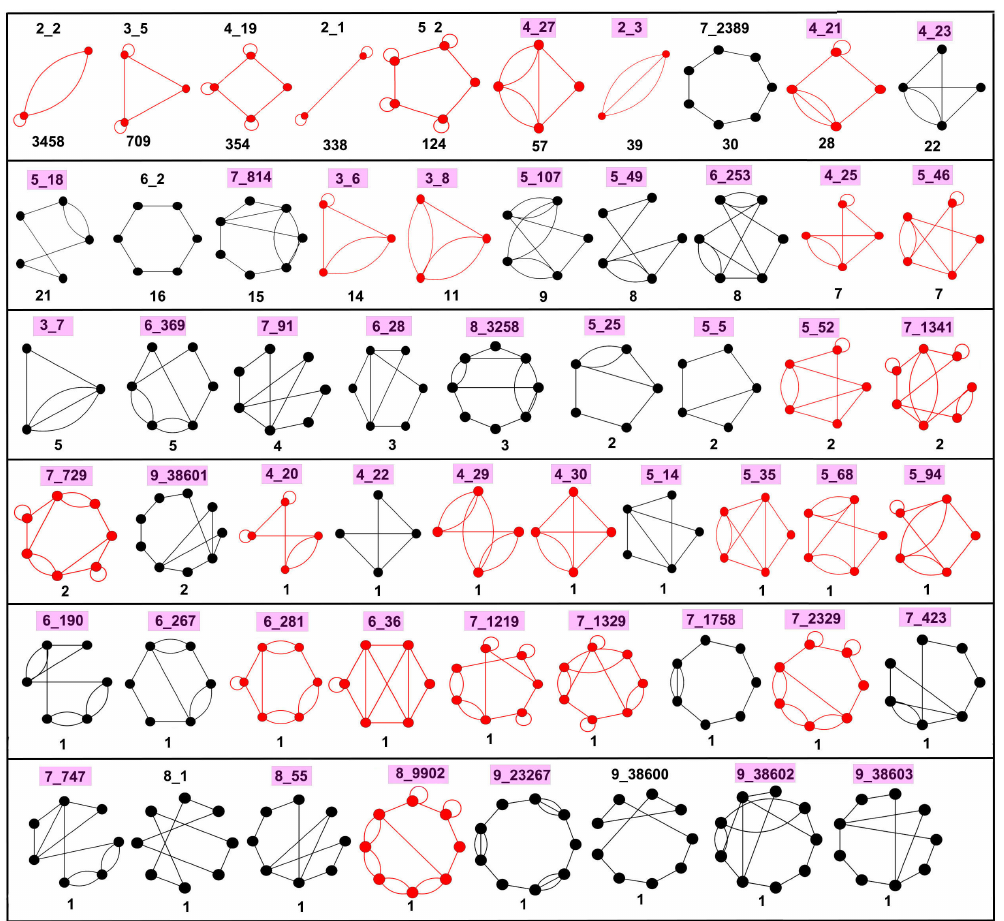
Figure 4. Subgraph block topologies with 2–9 vertices in decreasing order of occurrence frequency. The 56 subgraph block topologies with 2–9 vertices in the representative dataset of RNA structures are shown, along with graph IDs and number of occurrences. Red graphs are part of existing dual graph topologies corresponding to the representative RNA 3D structure dataset (Figure 3 and Supplementary Table S1). Black graphs are those that only emerge as subgraphs. The IDs of subgraphs with pseudoknots are highlighted in magenta. Subgraphs with 10 or more occurrences are shown in Figure 5 (pseudoknot-free) and Figure 6 (with pseudoknots). Atomic fragments corresponding to these 56 subgraph blocks are cataloged in the RAG-3Dual dataset of RNA 3D